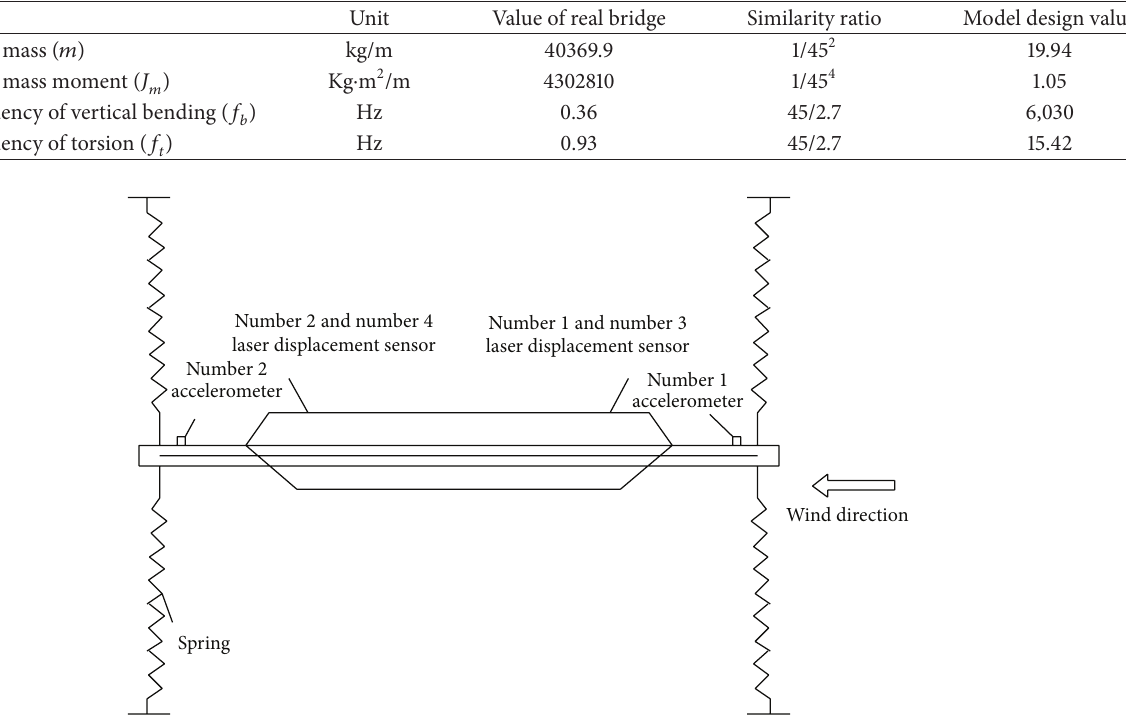
Table 2: Primary parameters of sectional model.